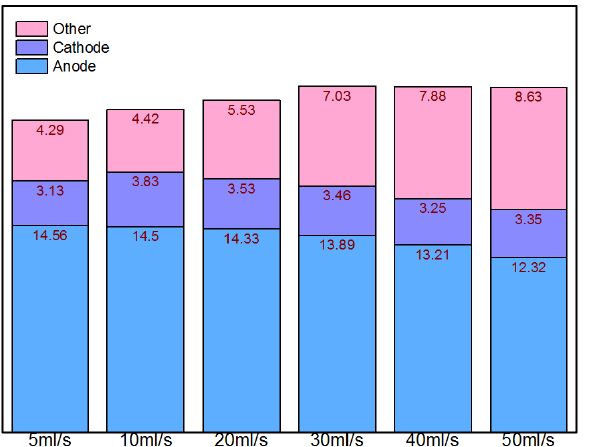
Figure 7. The cadmium content (g) of sponge at different flow rates and the distribution changes.